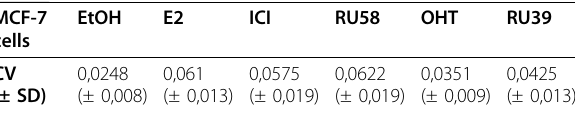
Table 1 Mean coefficient of variation and its standard deviation in MCF-7 cells treated with E2 and anti-